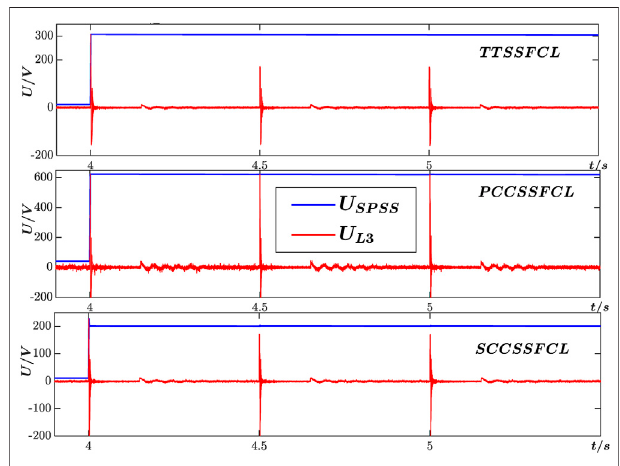
FIGURE 9 | The power acquisition process of the SPSSs under three repetitive